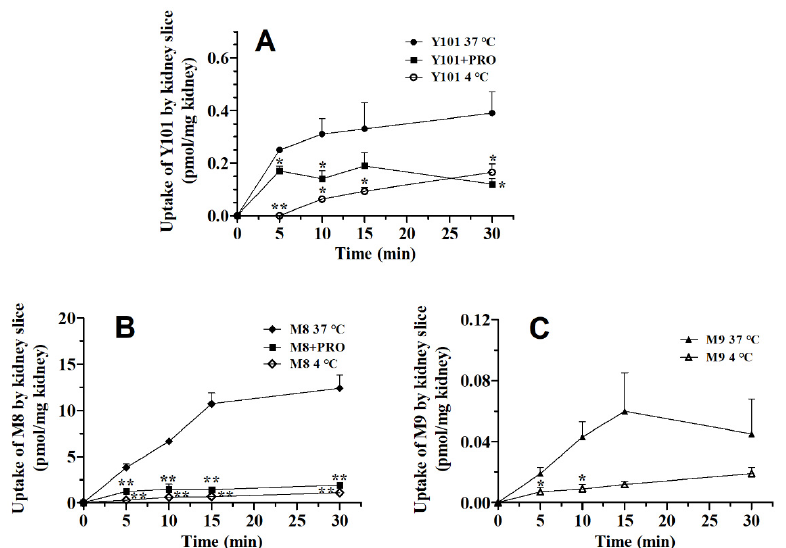
Figure 6. Time-dependent and temperature-dependent uptake of Y101 (2.0 µM, A ), M8 (5.0 µM, B ) and M9 (1.0 µM, C ) in kidney slices. The concentration of PRO was 100 µM. (*, p ˂ 0.05; **, p ˂ 0.01). Data are expressed as mean ± SD, n = 3.